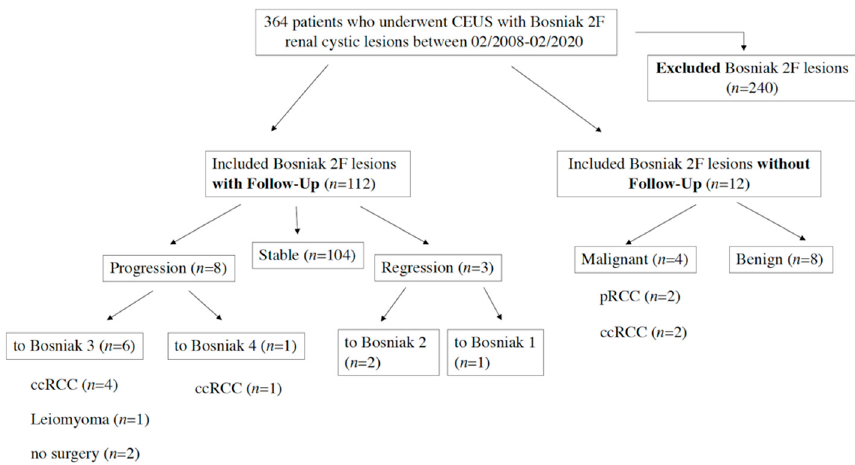
Figure 3. Flowchart illustrating included and excluded patients with Bosniak 2F renal cystic lesions. ccRCC—clear-cell renal cell carcinoma, pRCC—papillary renal cell carcinoma.